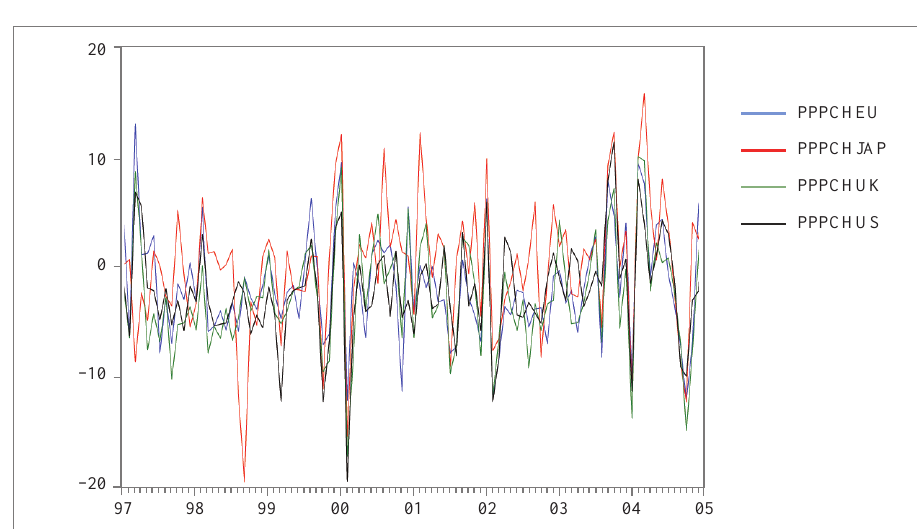
fig. 3. Purchasing power